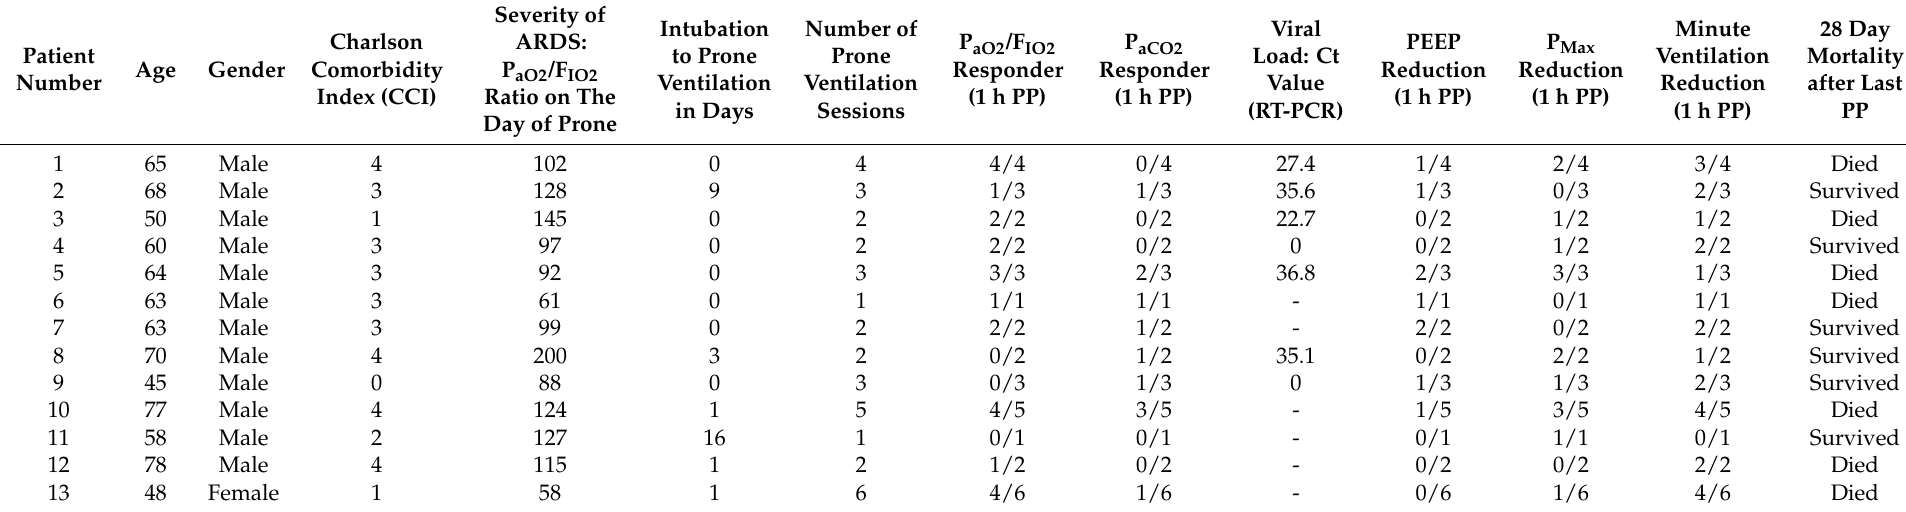
Table 2. Demographic and clinical characteristics of the